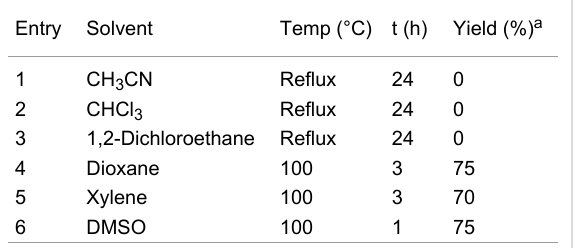
Table 3: Optimization studies for the synthesis of N , N ′-methylene- dibenzamide using DCMT-activated DMSO a . Entry Solvent